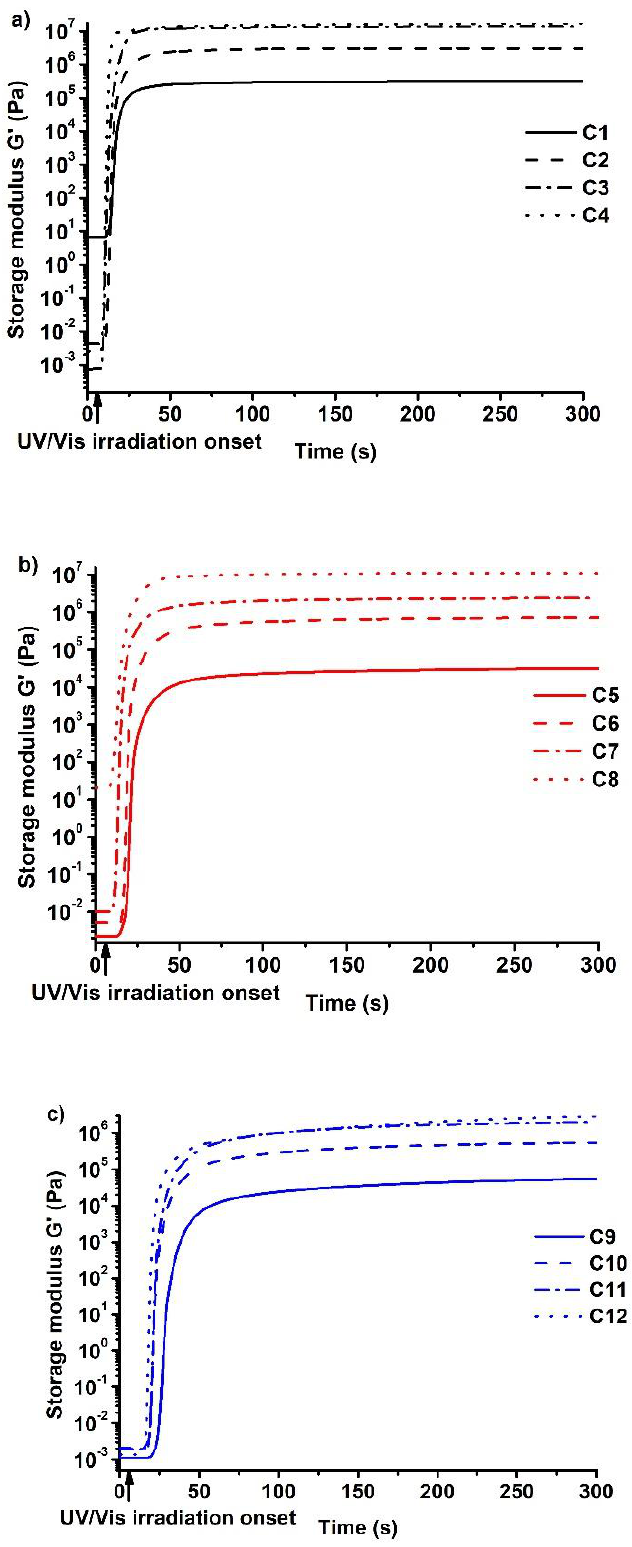
Figure 2. Dependency of storage modulus G’ of the resins C1 – C4 ( a ), C5 – C8 ( b ), and C9 – C12 ( c ) on the irradiation time.